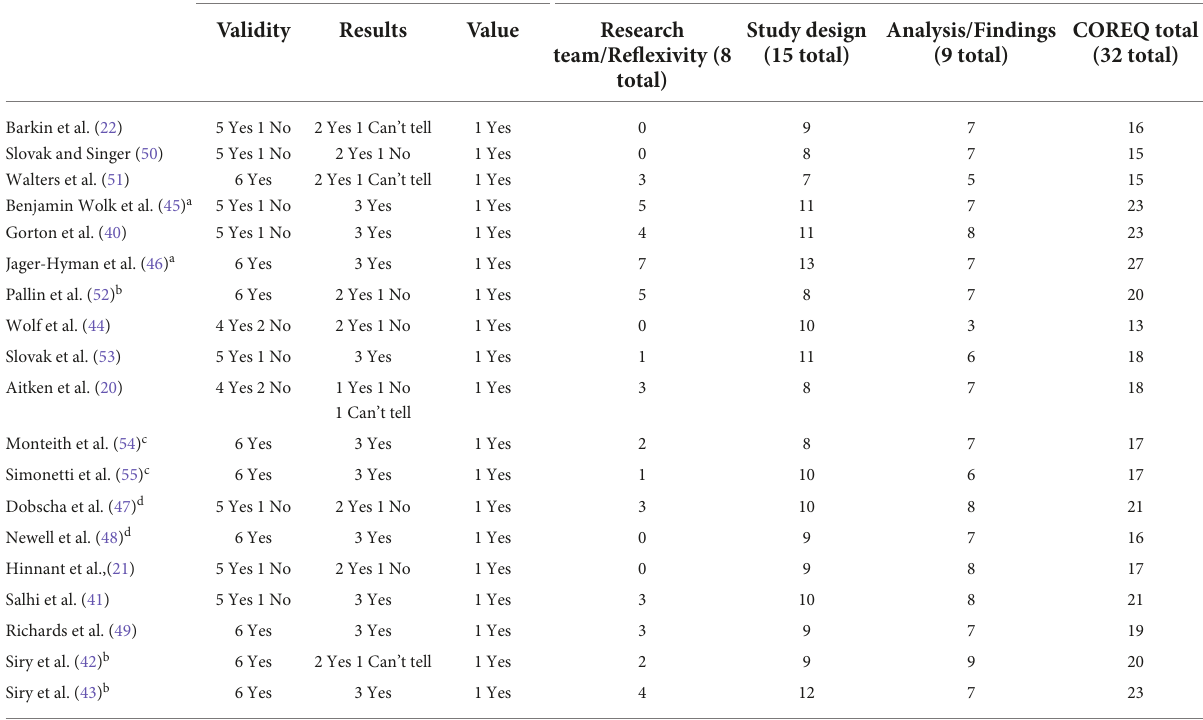
TABLE 2 Summary of study quality ratings by year of